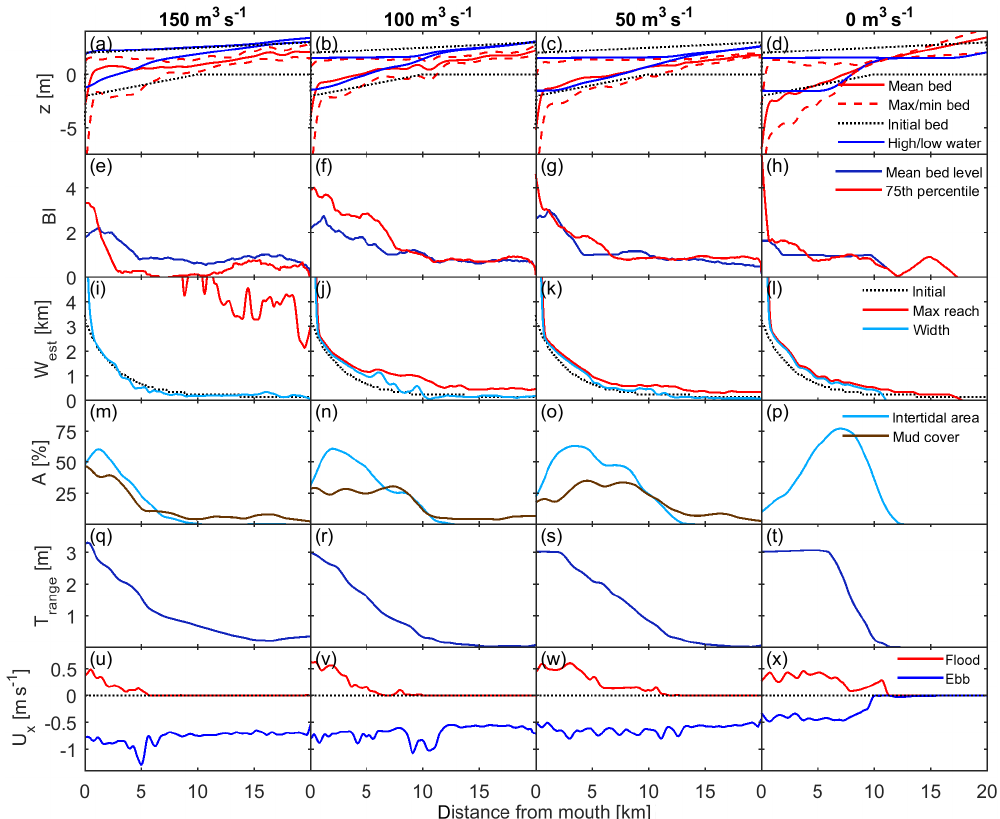
Figure A5. Hydrodynamics and morphology along estuaries with different discharge after 2000yr. From left to right (columns): model with river discharge of 150 (08), 100 (default, 01), 50 (07) and 0m 3 s − 1 (22). (a–d) Minimum, mean and maximum bed elevation, high and low water level and minimum and maximum initial bed level, (e–h) braiding index and (i–l) estuary width defined as the initial width, maximum reach over the whole scenario run, the width of wet cells in the model, width defined by a threshold value that is used to mask the cells that are around the dry–wet cell threshold. (m–p) Intertidal area and mud cover as a percentage of the total area, (q–t) tidal range and (u–x) peak ebb and flood